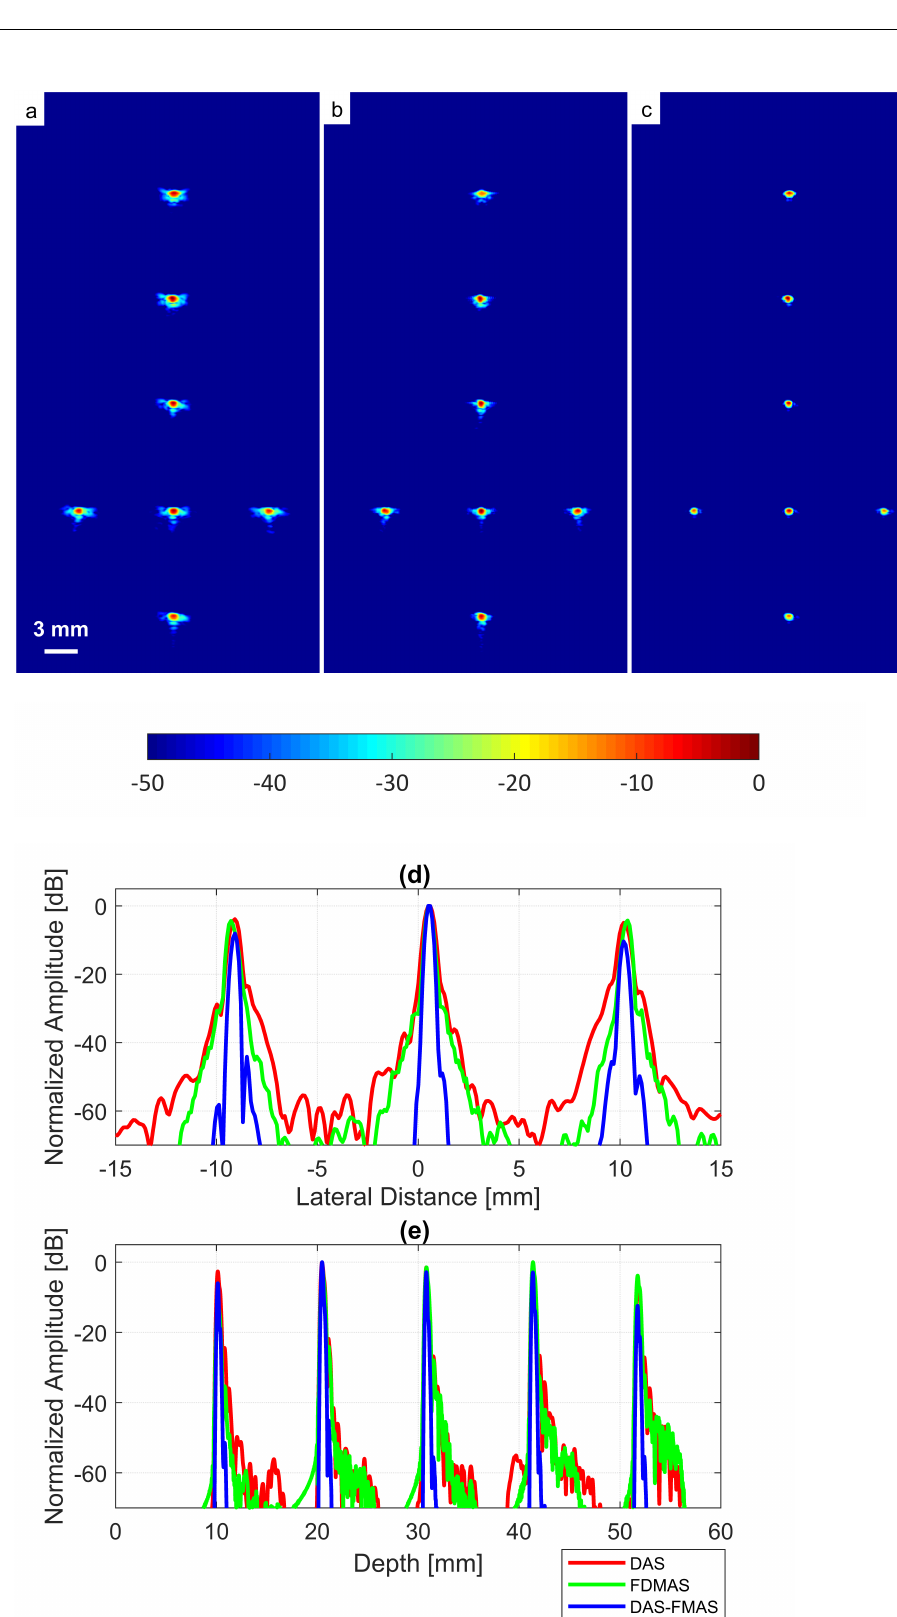
Figure 9. Wire phantom B-mode images were produced with N = 13 for ( a ) DAS, ( b ) FDMAS and ( c ) DAS-FMAS. ( d ) Beam profiles along the lateral direction at 45 mm depth. ( e ) Axial beam profiles along x = 1.0